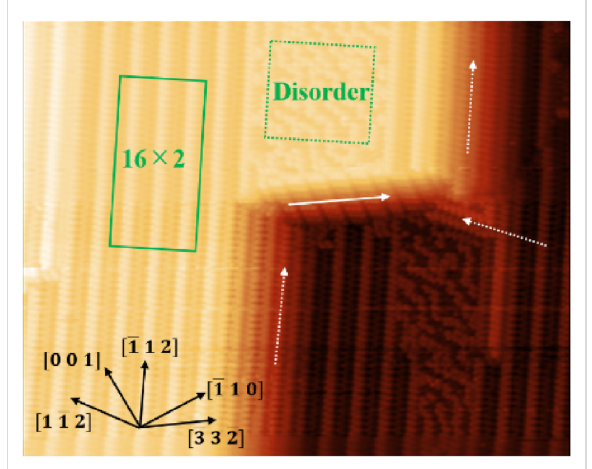
Figure 1: AFM image (100 × 80 nm 2 ) of the 16×2 reconstruction on Si(110). Solid and dotted rectangles represent the 16×2 reconstruction and disorder regions, respectively. The solid arrow indicates the step in direction. The dashed arrows indicate the (17 15 1) and (15 17 1) facets in the